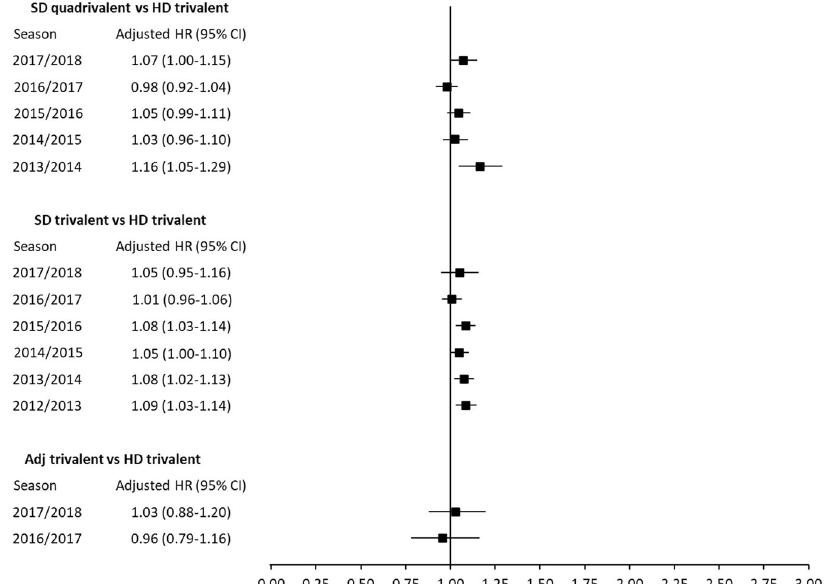
Fig. 2 Adjusted hazard ratios (HRs) for pneumonia (hospitalization/emergency room visit). The adjusted HR point estimates and 95% con fi dence intervals are presented for each comparison and each in fl uenza season. The high-dose trivalent vaccine is used as the reference